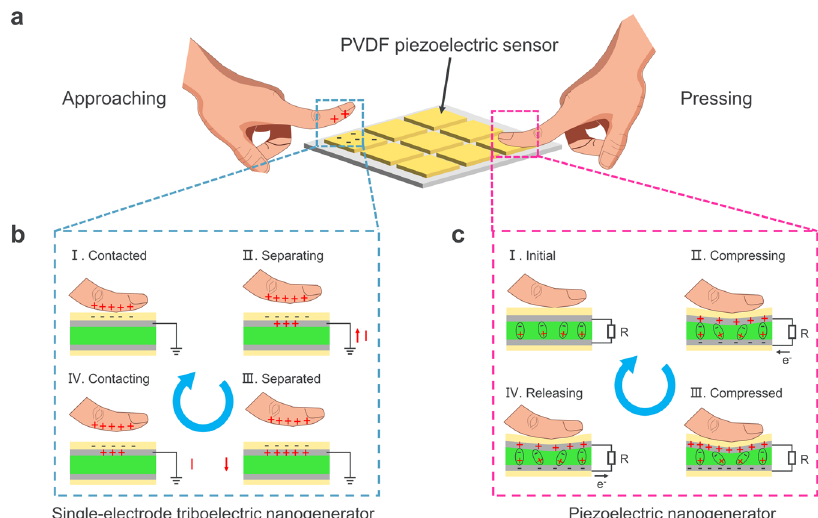
Fig. 1 Schematic of the existence of both SE-TENG and PENG during practical application of piezoelectric devices, but the time at which the signal is generated has distinct differences. a The human fi nger has positive charges and the surface of a piezoelectric pixel has negative charges (left). The piezoelectric material would experience elastic deformation when a human fi nger is pressing it and the piezoelectric effect would occur (right). b A SE- TENG is formed when using the positive fi nger touches the negative piezoelectric pixel again. The working mechanism of SE-TENG contains four stages including contacted, separating, separated, and contacting, the triboelectric signals will be generated in the stages of separating and contacting. c The working mechanism of PENG contains four stages including initial, compressing, compressed, and releasing. Piezoelectric signals will be generated in the stages of pressing and